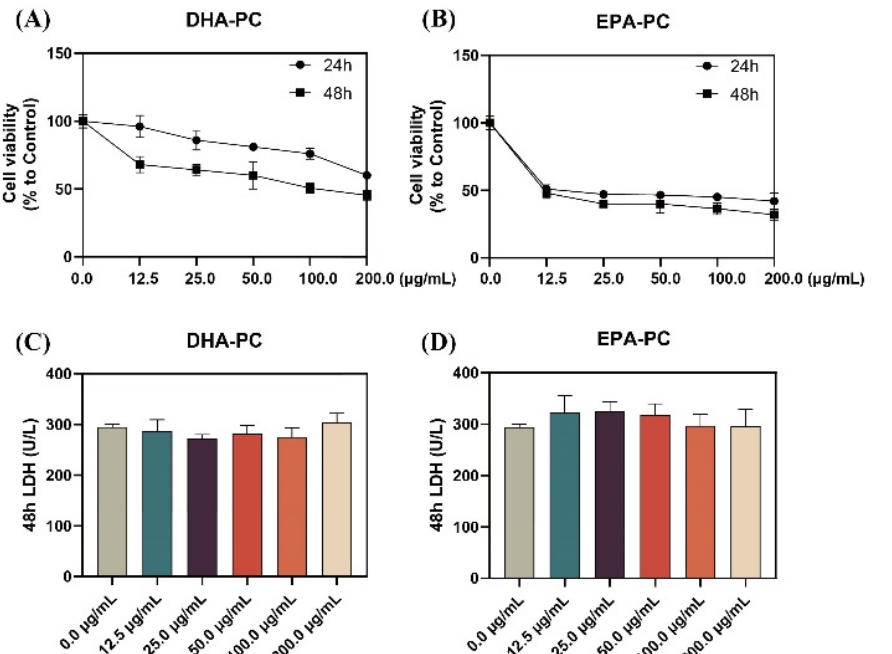
Figure 1. DHA-PC and EPA-PC inhibited 95D cells proliferation and exhibited non-toxicity to 95D cells. Evaluation of the effect of various concentrations of DHA-PC ( A ) and EPA-PC ( B ) on the cell viability of 95D cells. Evaluation of the effect of different concentrations of DHA-PC ( C ) and EPA-PC ( D ) on the LDH activity of 95D cells.